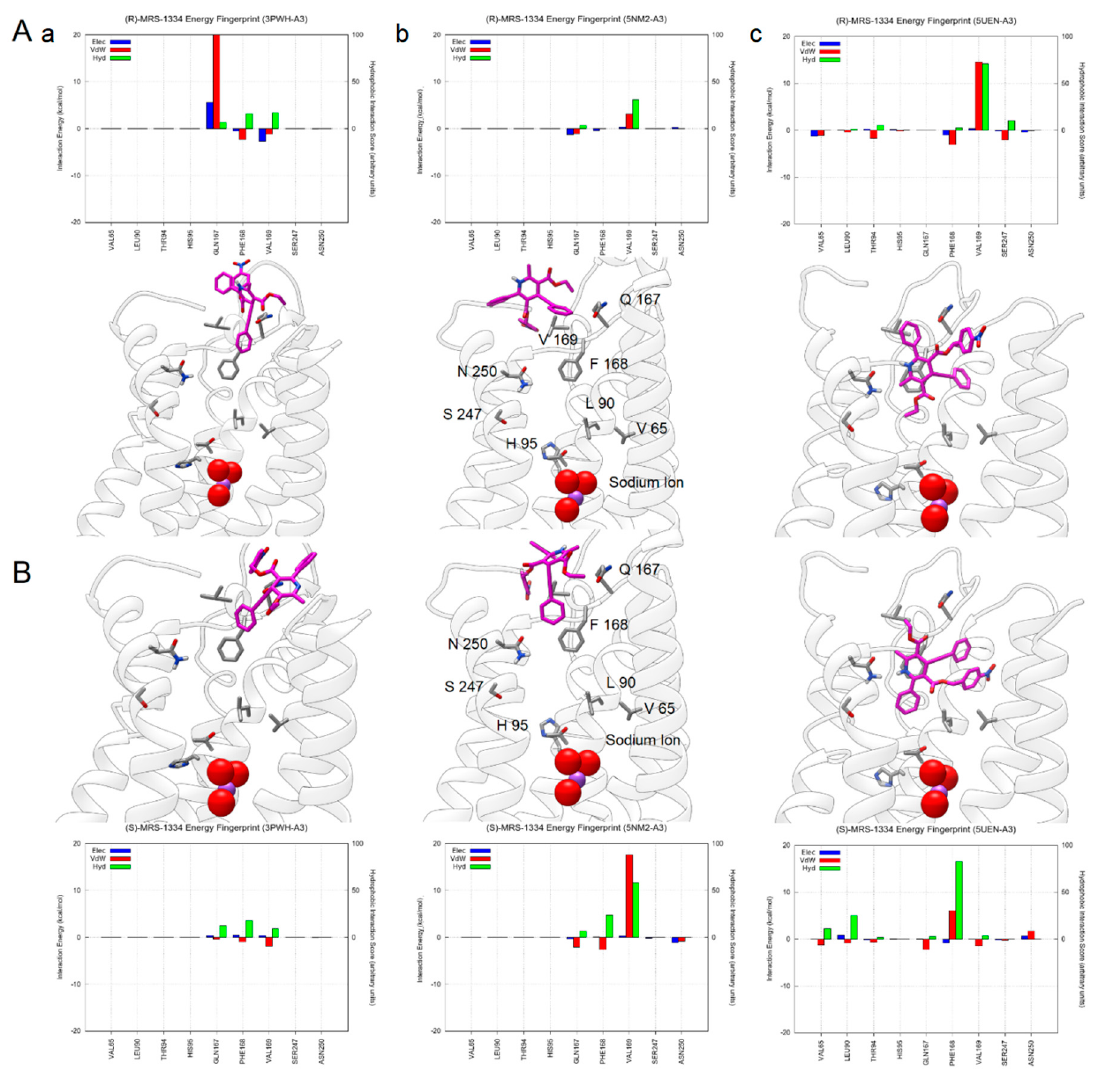
Figure 10. Per residue energy histograms and selected docking poses of ( 4R )-MRS1334 (panel A ) and ( 4S )-MRS1334 (panel B ) on either the hA2A-based models ( a , b ) or the hA 1 -based model ( c ).